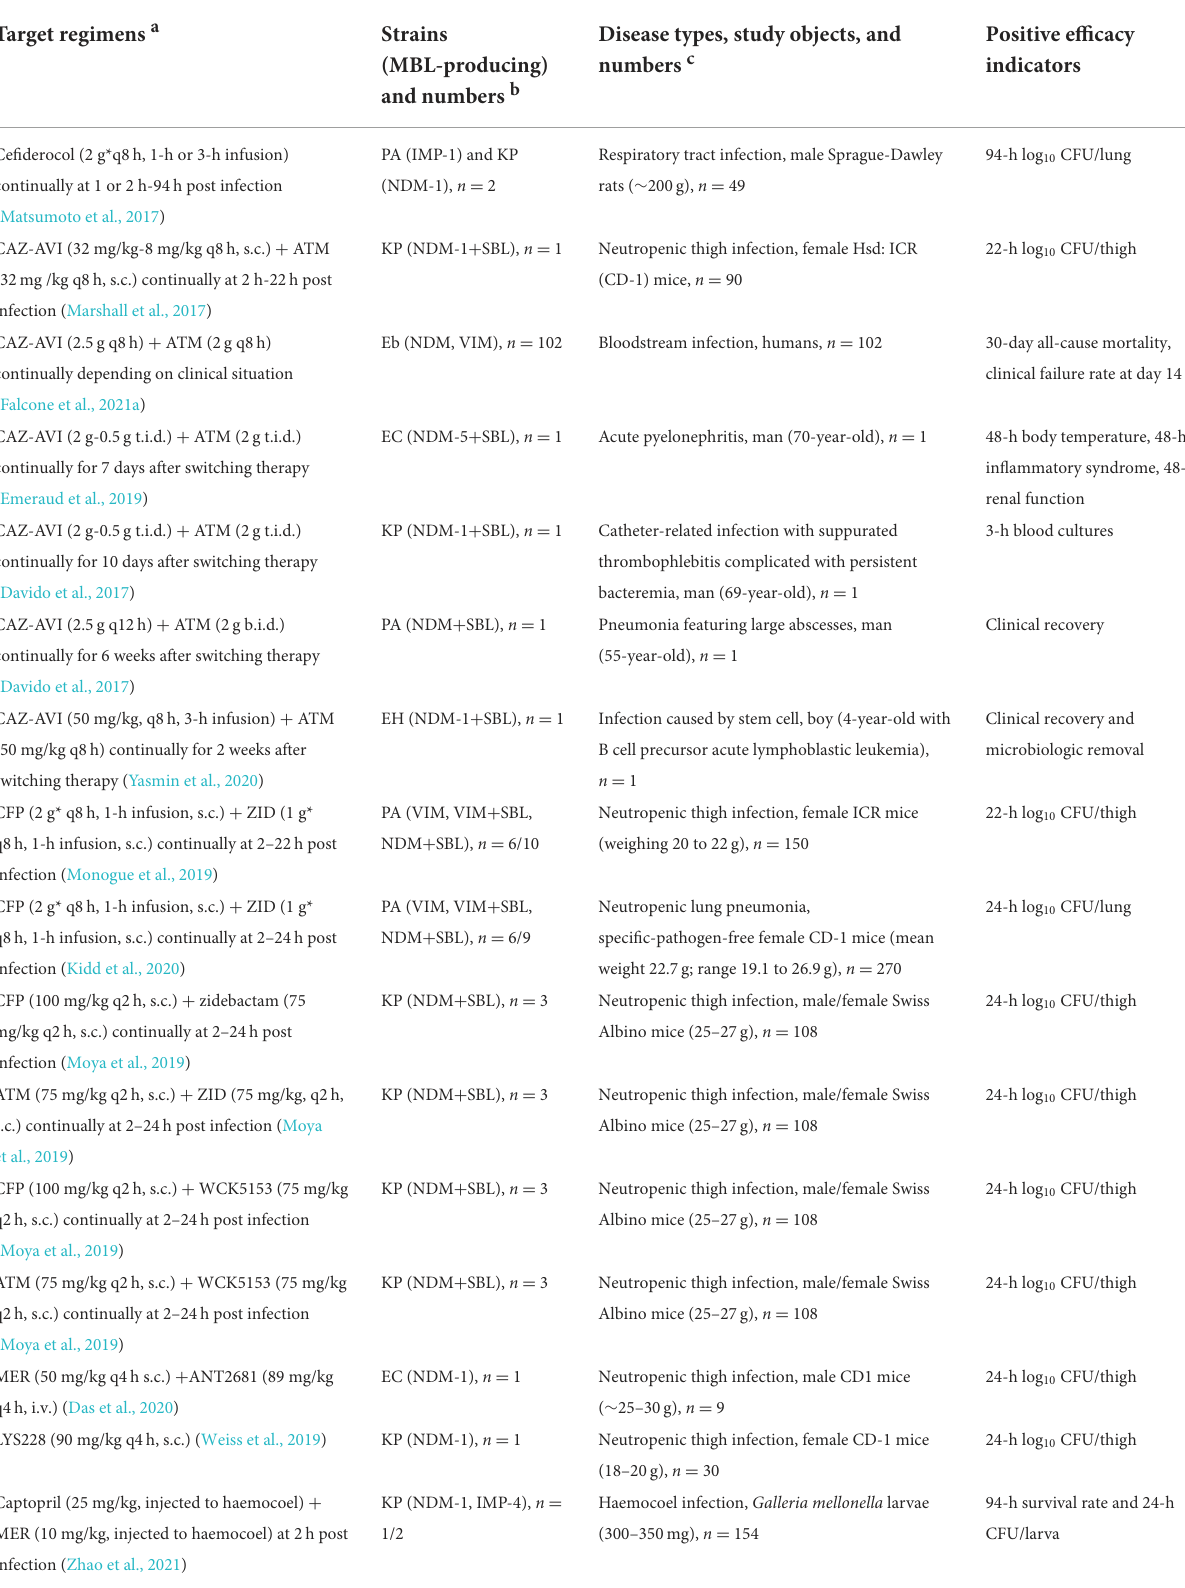
TABLE 2 In vivo efficacy of novel drug strategies vs. metallo- β -lactamase producers adapted from references. Target regimens a Strains